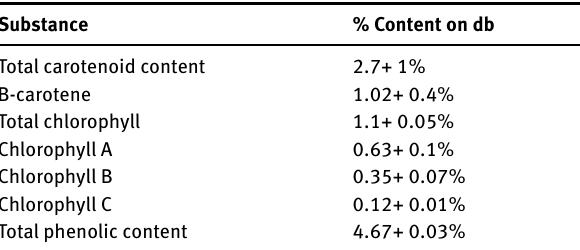
Table 5: Content of Chlorella vulgaris in carotenoids, chlorophyll and phenols on a dry basis (db)